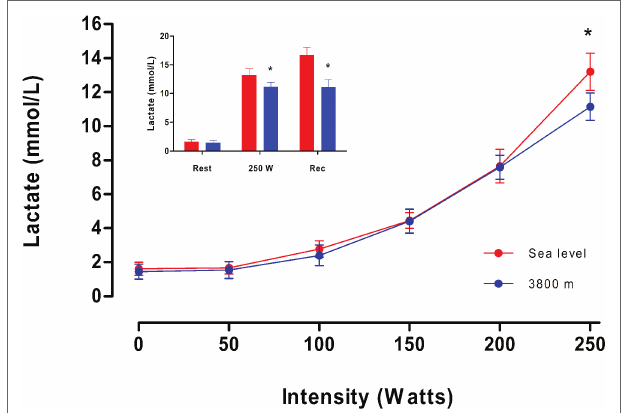
FIGURE 4 | Average values of plasmatic lactate concentration (mmol/L) as a function of intensity (in W) obtained on the fourth day at sea level and high altitude. In the inserted figure, red bars represent the average lactate concentration at Sea level; blue bars are the average lactate concentration (mmol/L) at 3,800 m. * represents a significant difference between sea level vs. high altitude and a cross represents a significant difference compared to rest ( p < 0.05).